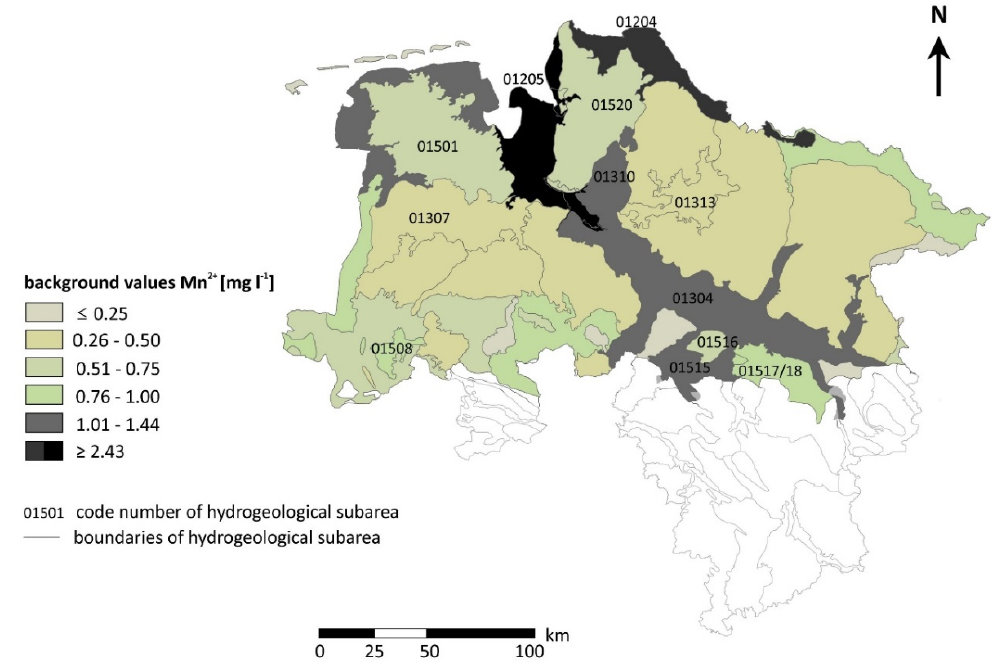
Figure 3. Results of the derivation of background values for Mn in 37 hydrogeological subareas with code numbers (e.g., 01307). The background values were classified into six ranges of concentration with the tidal wetlands being assigned extreme values ≥ 2.43.